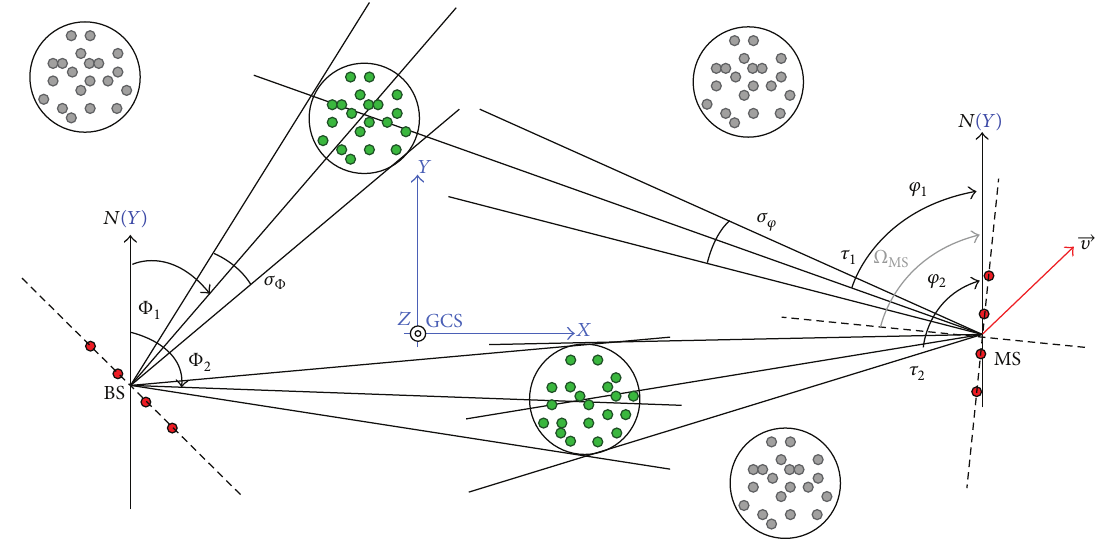
F 2: WINNER II channel